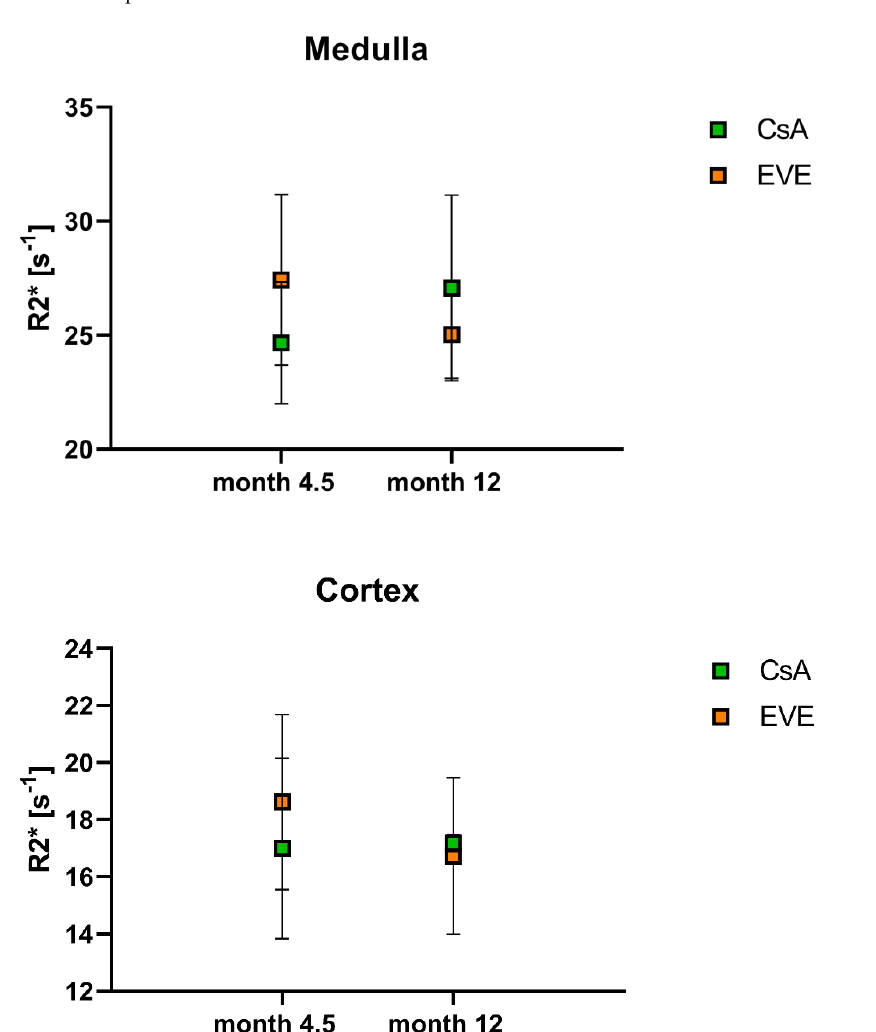
Figure 6. BOLD - derived transverse relaxation rate. Transverse relaxation rate R2* according to medication group and time-point in medulla and cortex.